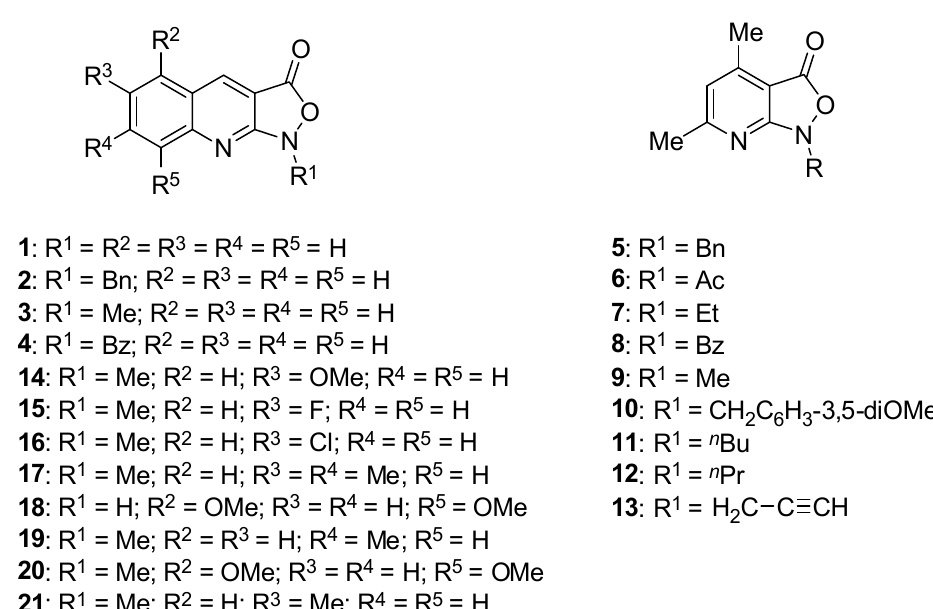
Figure 1. The investigated pyrido ‐ and quinolino ‐ isoxazolones.